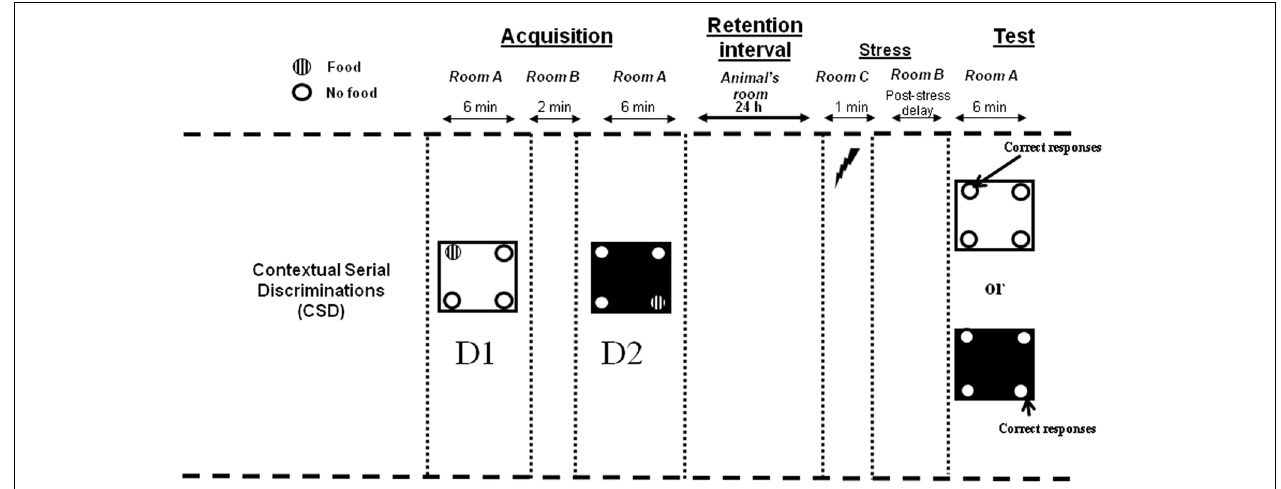
FIGURE 1 | Contextual Serial Discrimination: at the acquisition phase, mice performed two consecutive spatial discriminations varying by the color and texture of the floor, i.e., D1: Discrimination 1 and D2: Discrimination 2. For each discrimination, only one hole out of the 4 holes of the apparatus was baited (hashed circles). A 24-h delay was interpolated between the acquisition and test phases, during which mice were returned in the animal room. Fifteen minute (post-stress delay)